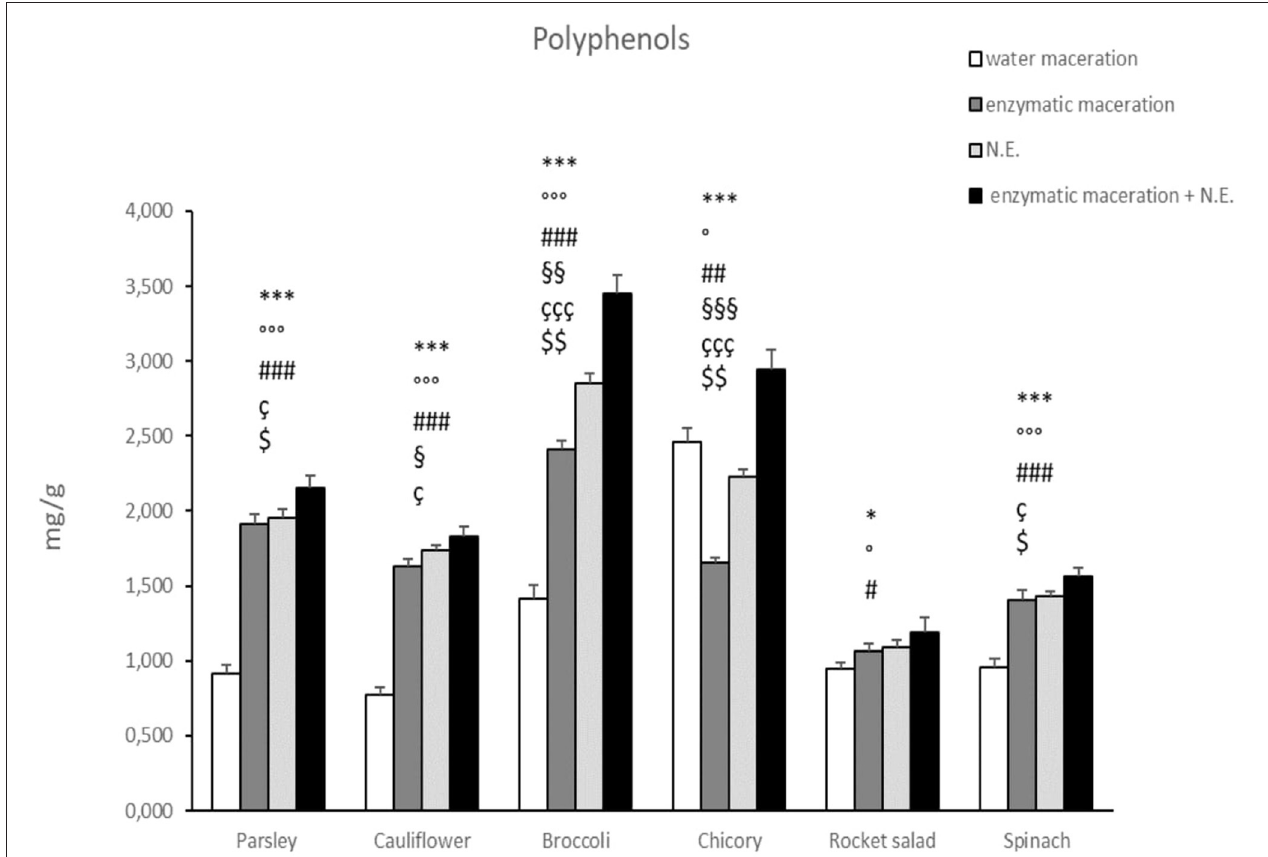
FIGURE 1 | Polyphenolic content (mg/g) in the different extracts obtained from vegetable waste. Data are expressed as mean values ± standard deviation. Statistical analysis: within-group comparison (Polyphenols at different extraction methods) carried out by repeated measures analysis of variance. Level of significance: * p < 0.05; ** p < 0.01; *** p < 0.001 expressed with comparison symbols: (*) water maceration vs. enzymatic maceration, ( ◦ ) water maceration vs. N.E., (#) water maceration vs. enzymatic maceration + N.E., (§) enzymatic maceration vs. N.E., (ç) enzymatic maceration vs. enzymatic maceration + N.E., ($) N.E. vs. enzymatic maceration + N.E. N.E., Naviglio Estrattore®. Statistical analysis: Continuous variables were reported as mean values ± standard deviation (SD), and were analyzed using nonparametric tests (i.e., Friedman and Wilcoxon test, as appropriate), since these variables were not normally distributed (based on the Shapiro-Wilk statistic). All tests were two-sided and a p < 0.05 was considered as statistically